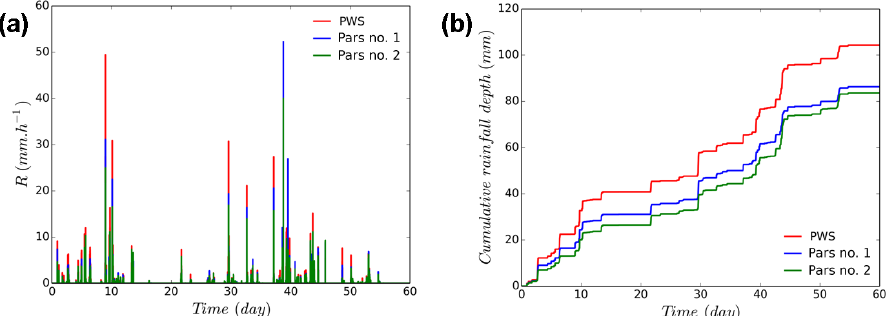
Figure 2. Temporal evolution of the rain rate and cumulative rainfall depth over the months of the measurement campaign for the three disdrometers.